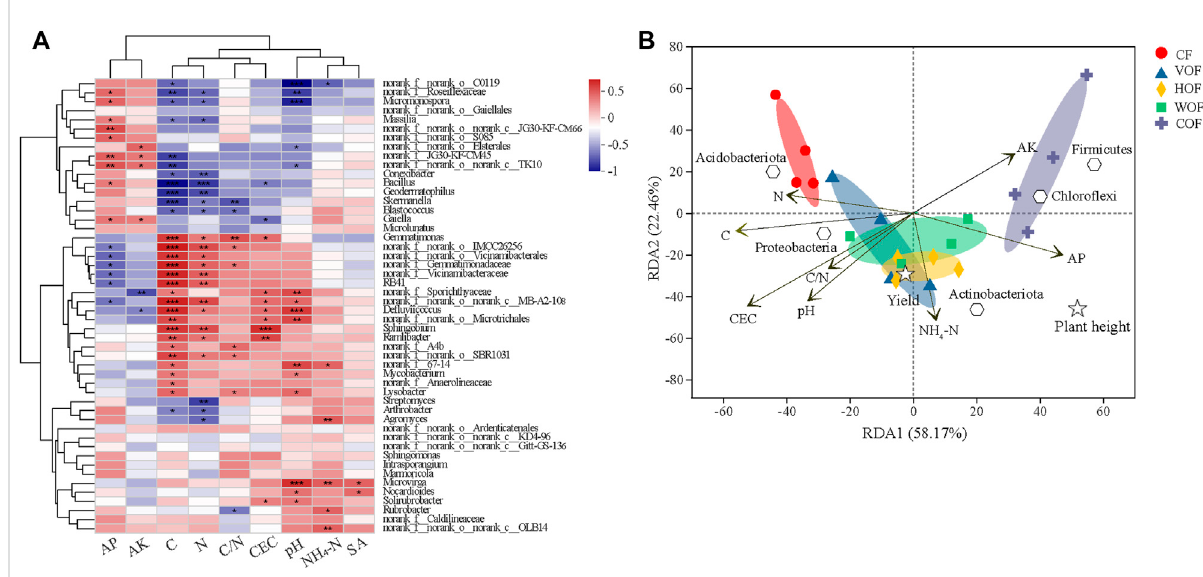
FIGURE 7 Spearman correlation heatmap between bacterial genera and soil environmental factors (A) and RDA of the relationship among bacterial phylum,samples,environmentalvariables,tobaccoheight,andleafyield (B) .*,**,and***indicatestatisticalsigni fi canceat p < 0.05, p < 0.01,and p < 0.001, respectively. AP, AK, and SA represent the soil available P, available K, and sinapic acid contents. CF, VOF, HOF, WOF, and COF represent the treatments of tobacco-special chemical fertilizer, vermicompost-based, humic acid-based, wood biochar-based, and compound functional organic fertilizers,